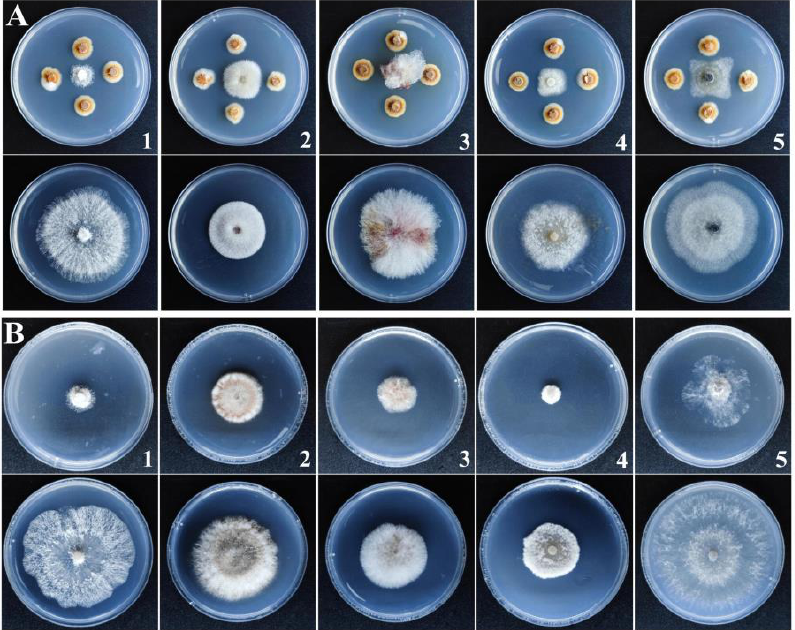
Figure 5. Antifungal spectrum of strain J-1 ( A ) and 200 mL L − 1 aseptic filtrate ( B ) against five phytopathogenic fungi. (1. Diaporthe eres , 2. Epicoccum sorghinum , 3. Fusarium graminearum , 4. Phomopsis sp., and 5. Botryosphaeria dothidea ).